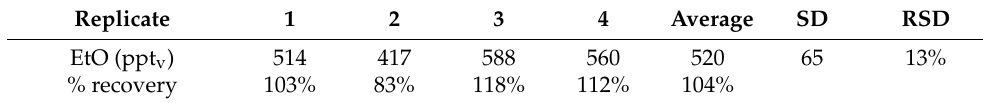
Table 8. Precision and accuracy study results, done in 50% humid air.